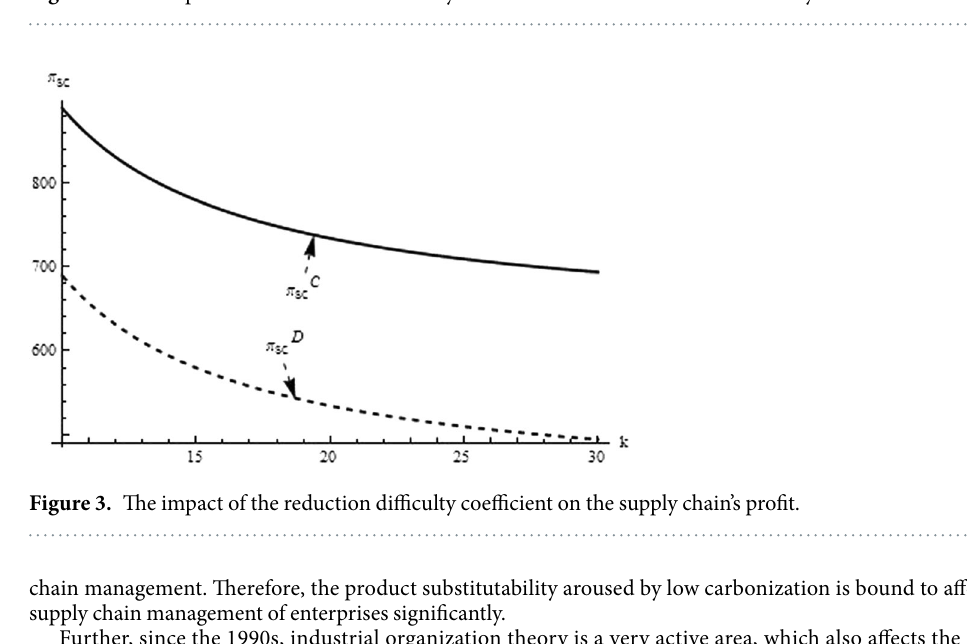
Figure 2. The impact of the reduction difficulty coefficient on carbon emission intensity.